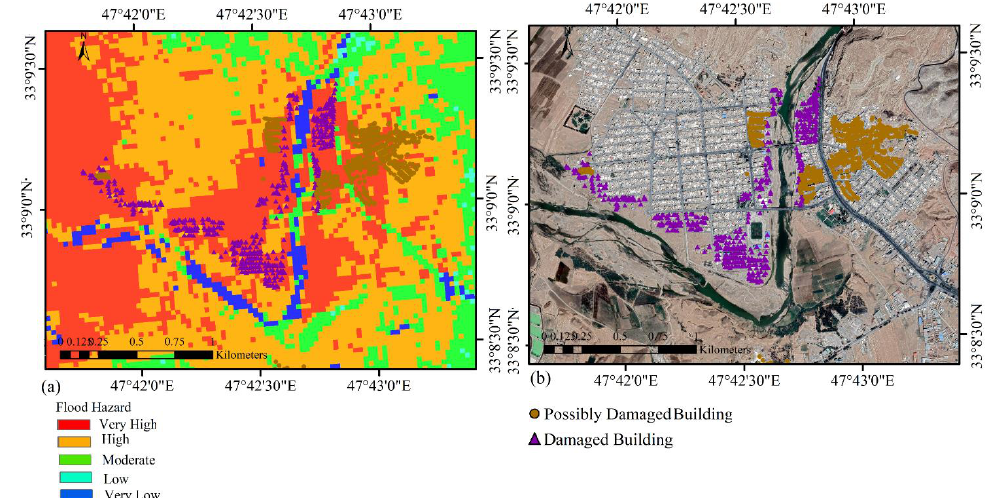
Figure 10. Buildings/Properties which were affected by the flood event in Pol-e Dokhtar in April 2020: ( a ) the flood hazard map in Pol-e Dokhtar produced using the proposed method, ( b ) Aerial photo of the affected areas in Pol-e Dokhtar during flood on April 2020 using the Copernicus Emergency Management Service (CEMS) reports.